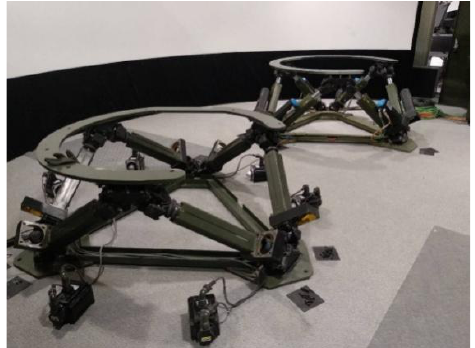
Figure 3. The physical object of the six-degrees-of-freedom motion platform.